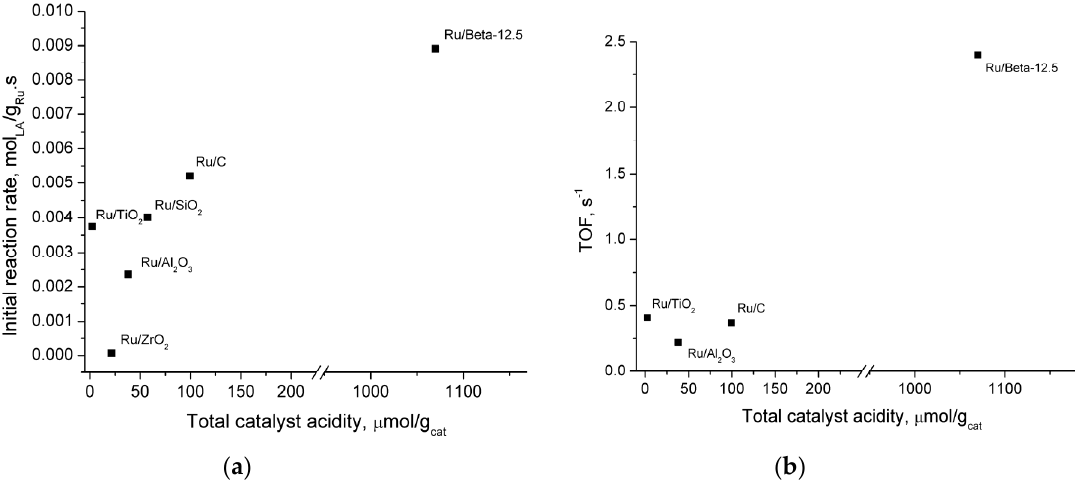
Figure 7. Initial reaction rates and TOF (turnover frequency) values versus the total acidity of the catalysts for LA hydrogenations using supported Ru catalysts. ( a ) Initial reaction rate, ( b ) TOF. The initial reaction rates and TOF values versus the specific surface area are given in Figure 8.